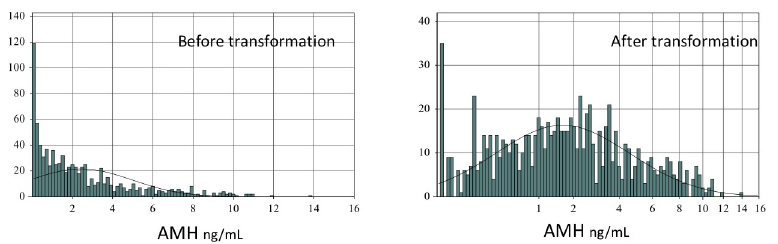
Fig 3. Data distribution of AMH before (left) and after transformation where the scale is adjusted to fit the AMH power transformation (right).